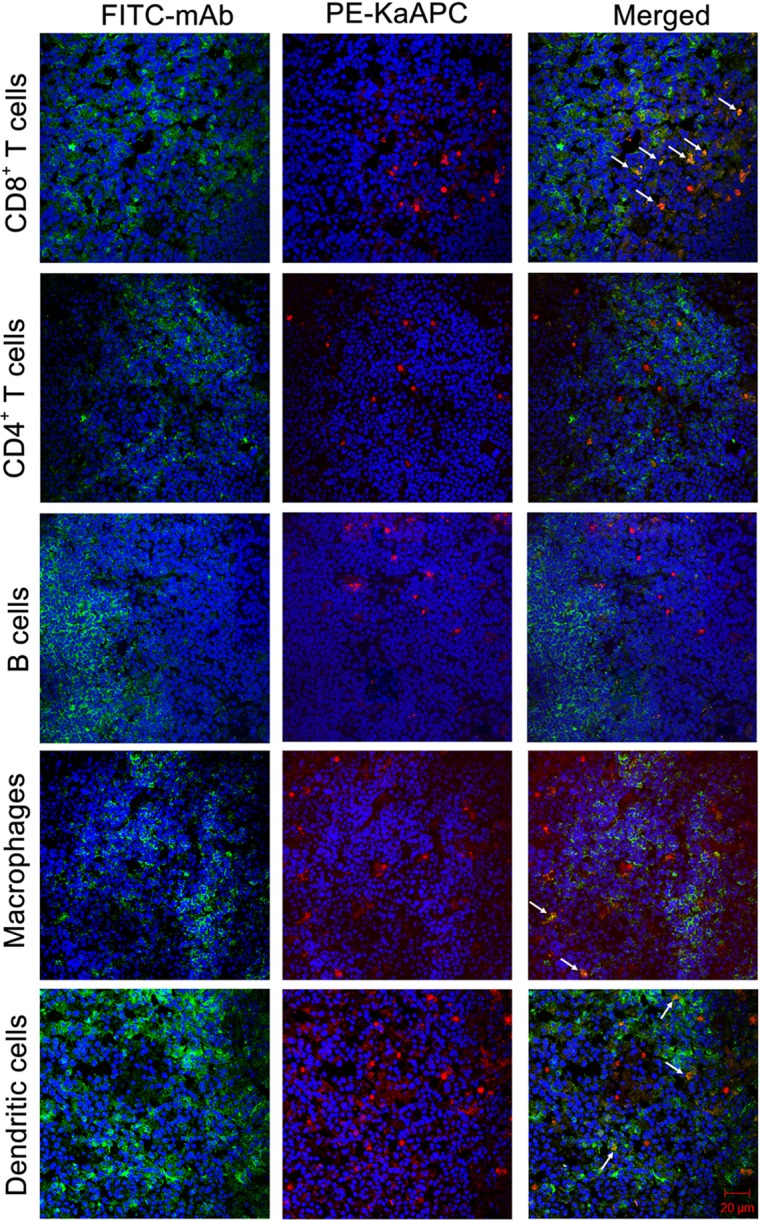
Confocol fluorescence imaging of killer artificial antigen-presenting cells (KaAPCs) with CD8+ T cells, CD4+ T cells, B cells, macrophages, and dendritic cells (DCs) in spleen section. R-Phycoerythrin (PE)-coupled KaAPCs were injected i.v. into the grafted bm1 mice on day 9, and spleens were collected 4 h later for the preparation of frozen sections. CD8+ T cells, CD4+ T cells, B cells, macrophage, and DCs were then stained by fluorescein-5-isothiocyanate (FITC)-labeled monoclonal antibodies (mAbs), respectively, and followed by confocol imaging in the marginal zone, red pulp, or white pulp of spleen section at 400× magnification. Many CD8+ T cells, macrophages, and DCs distributed in the marginal zones and red pulps, but most of B cells and CD4+ T cells could be observed in red pulps. Meanwhile, the PE-KaAPCs were mainly found in the marginal zones and red pulps.